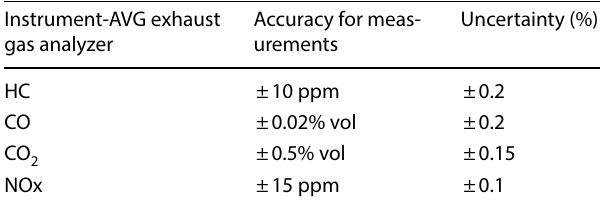
Fig. 3 The photographic view of the experimental setup (VCR engine) used Table 4 Details of specifications: engine used and instruments